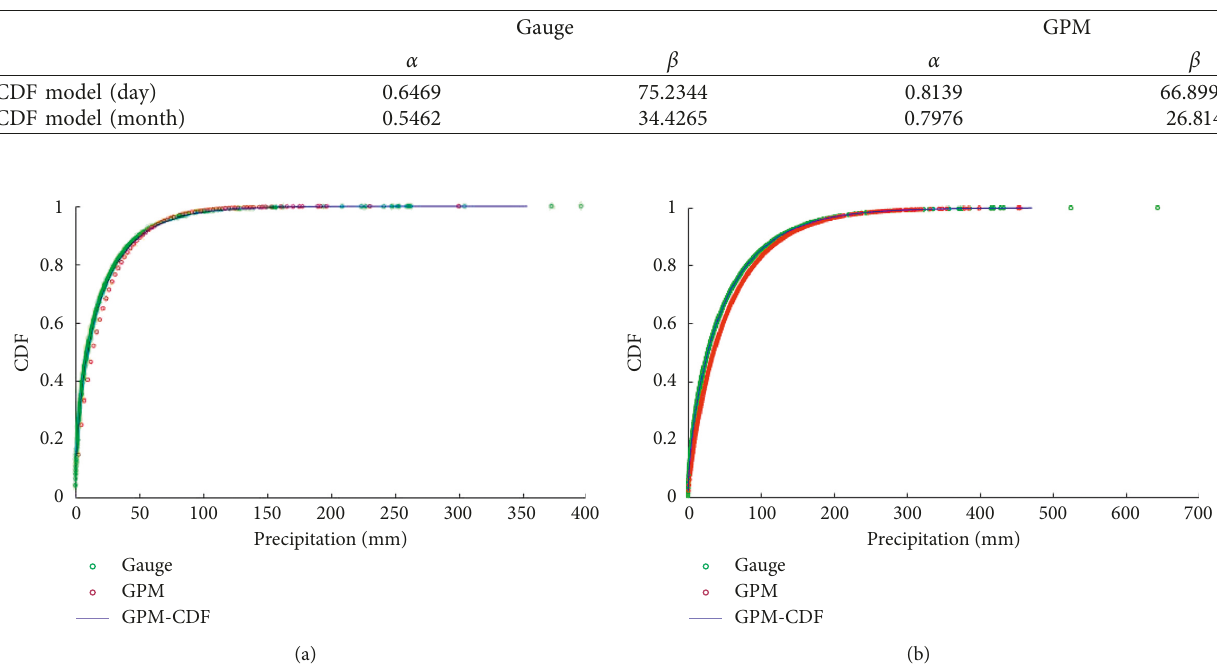
Table 4: CDF model shape parameter α and scale parameter β .